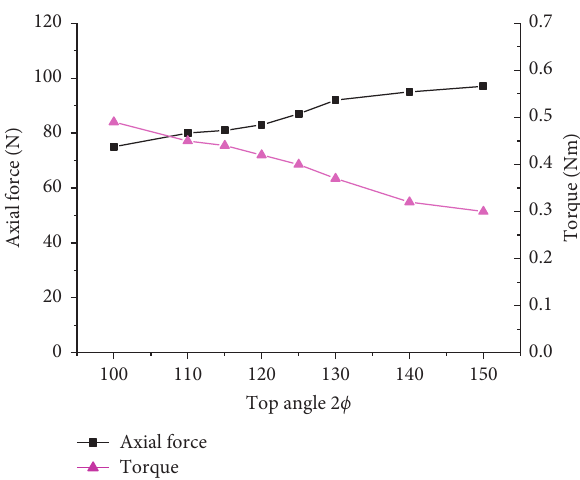
Figure 7: Delamination factor Fd at varying point